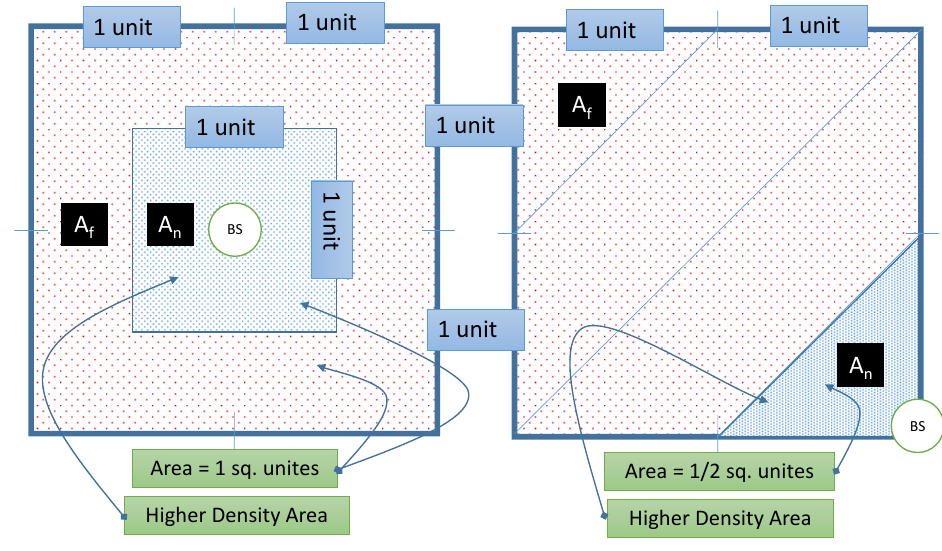
Figure 18. The area coverage of a central sink is higher than a peripherally sink. To balance the higher data rate nearby the sink, we acquire a higher density sensor